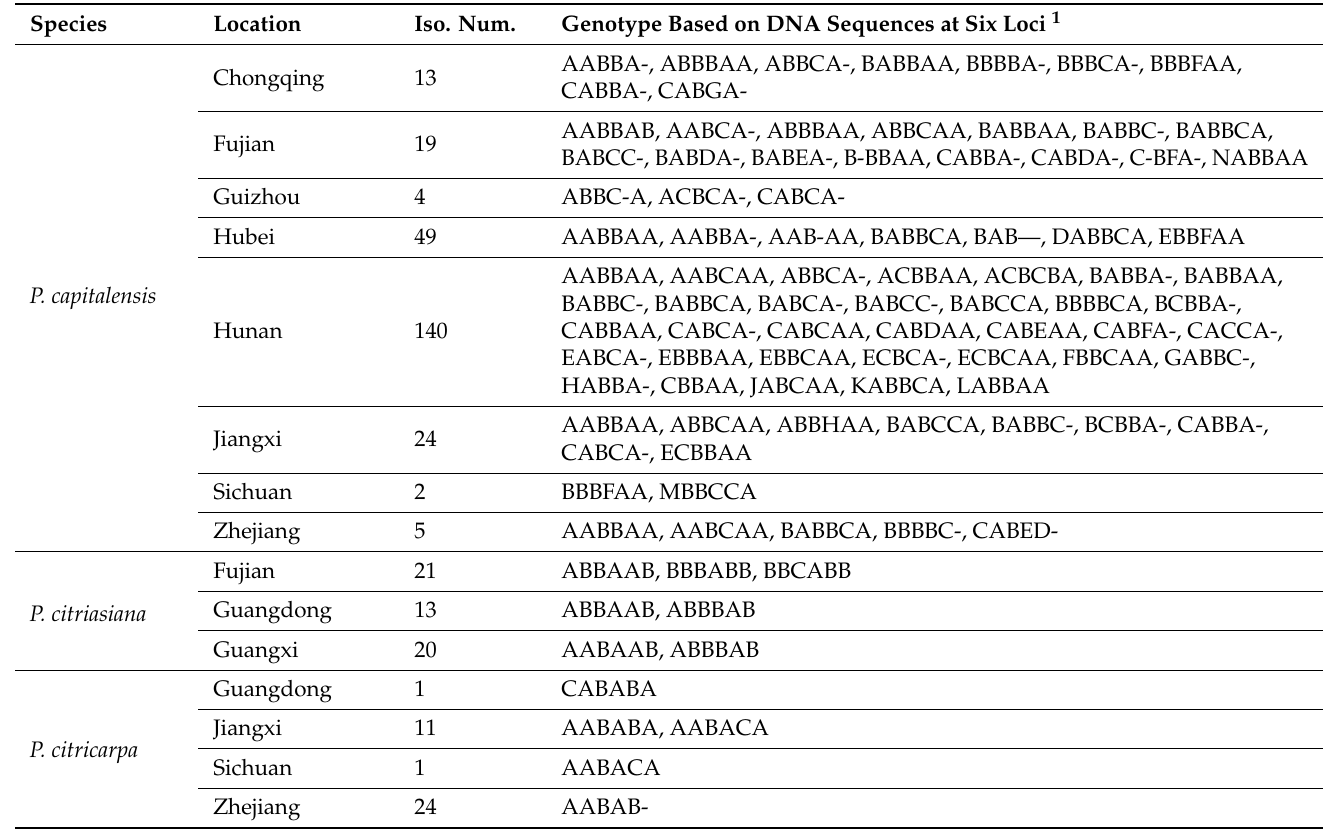
Table 1. Information on Phyllosticta isolates collected from citrus in China and their genotype statistics based on geographical origin. Iso. Num. Genotype Based on DNA Sequences at Six Loci